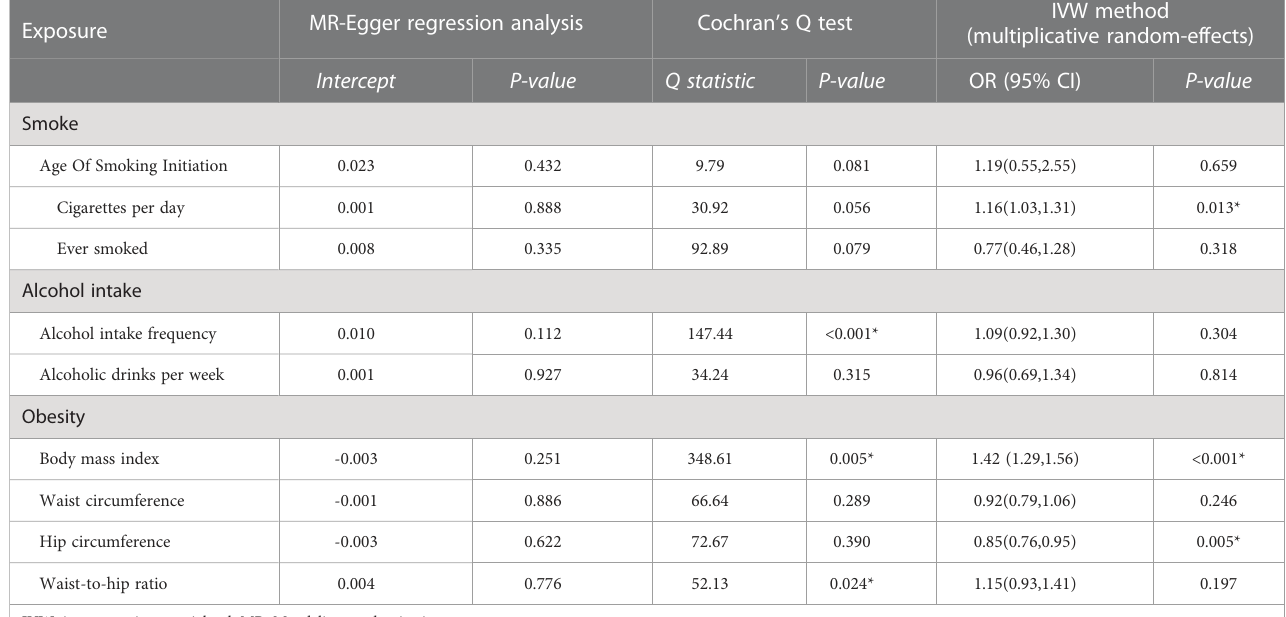
TABLE 3 Sensitivity test of Mendelian randomization analyze of the associations between unhealthy lifestyle and risk of DR.